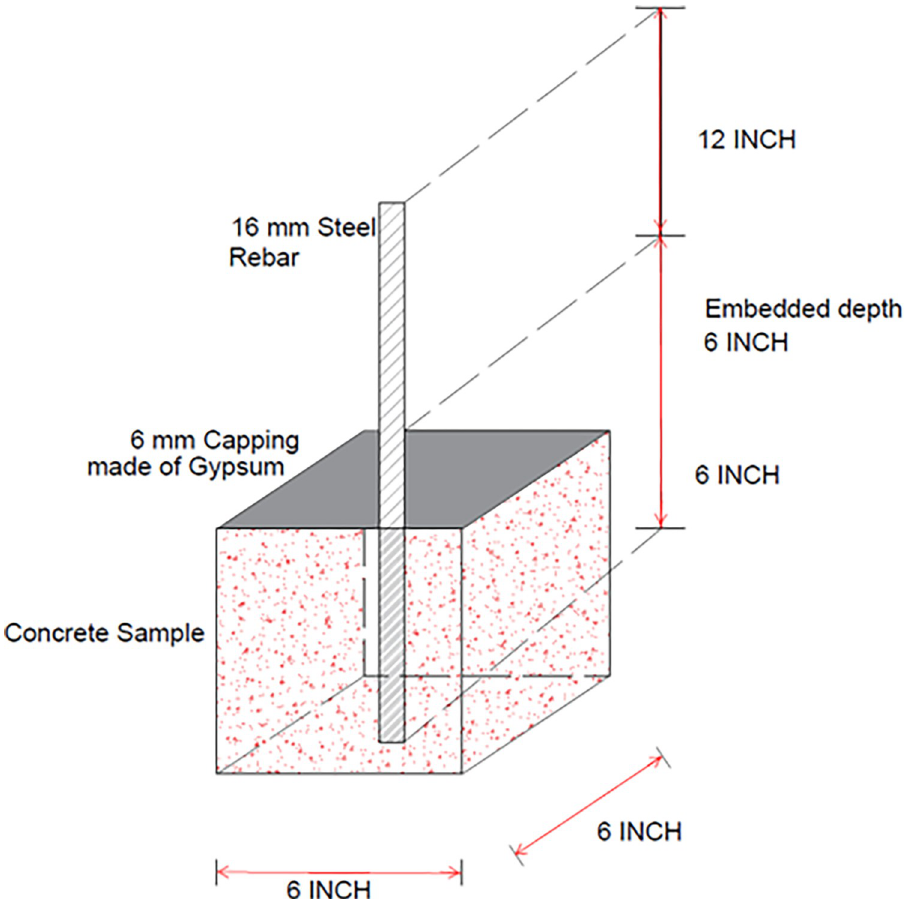
Fig 4. Test setup of bond